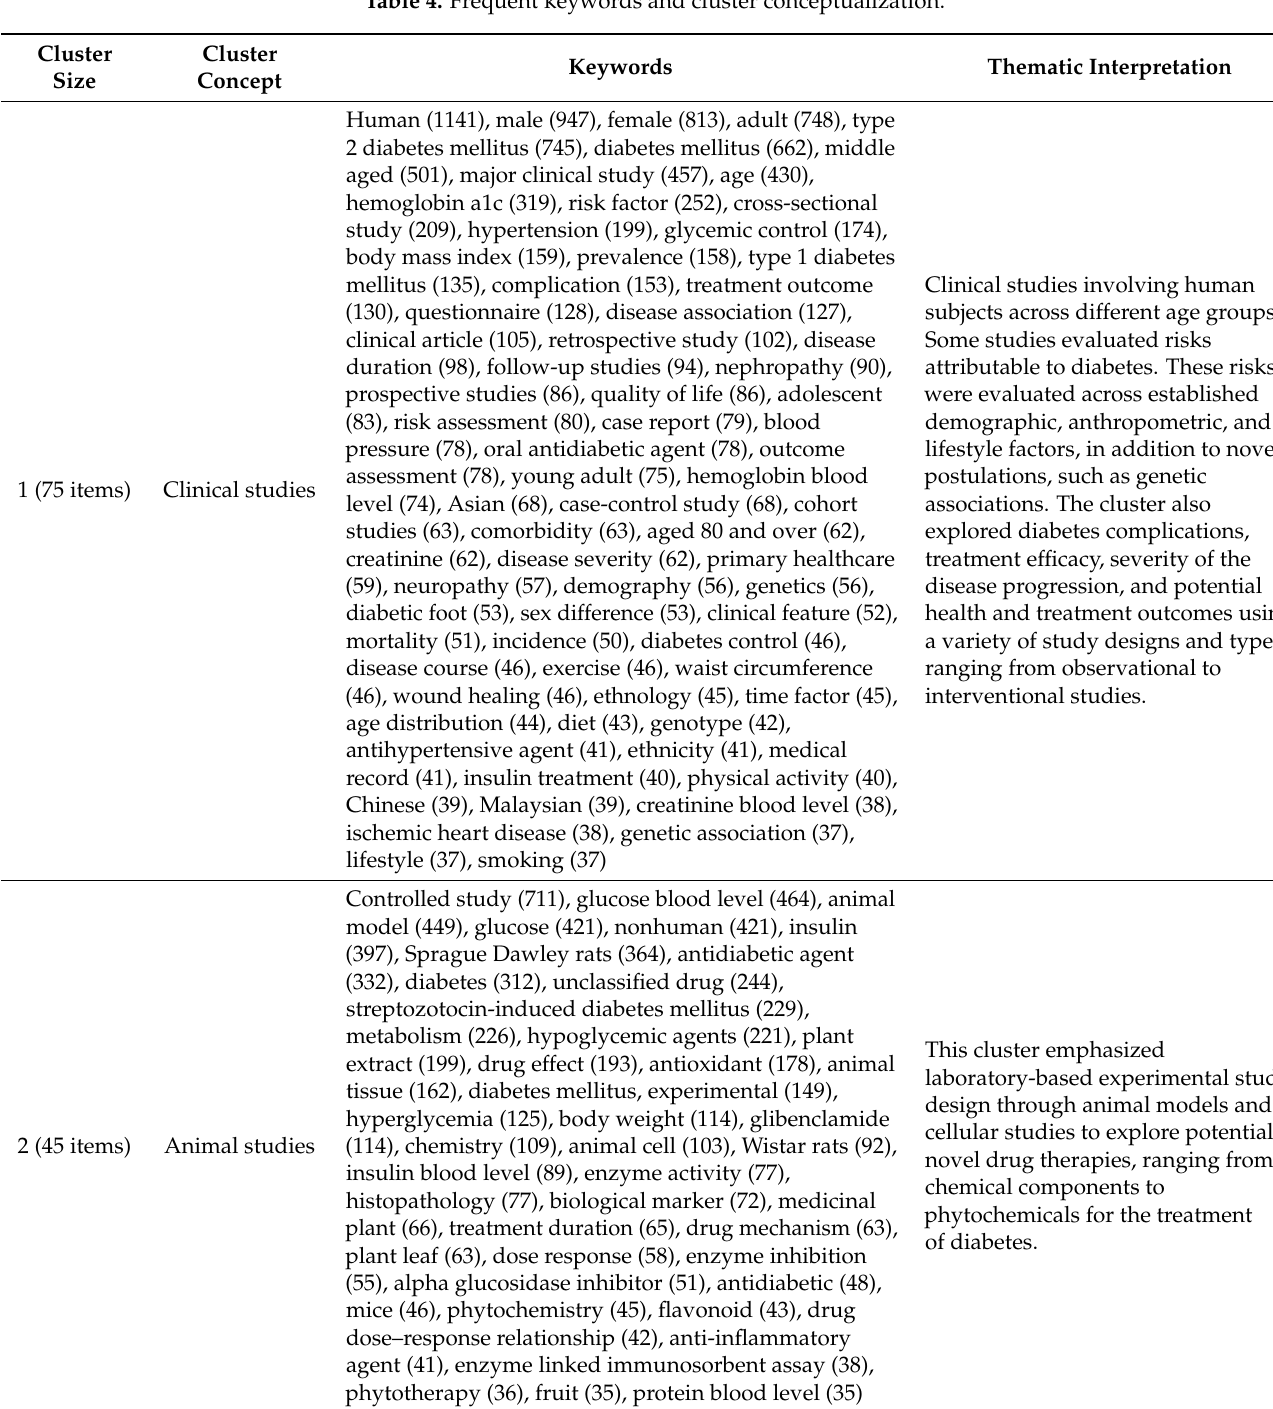
Table 4. Frequent keywords and cluster